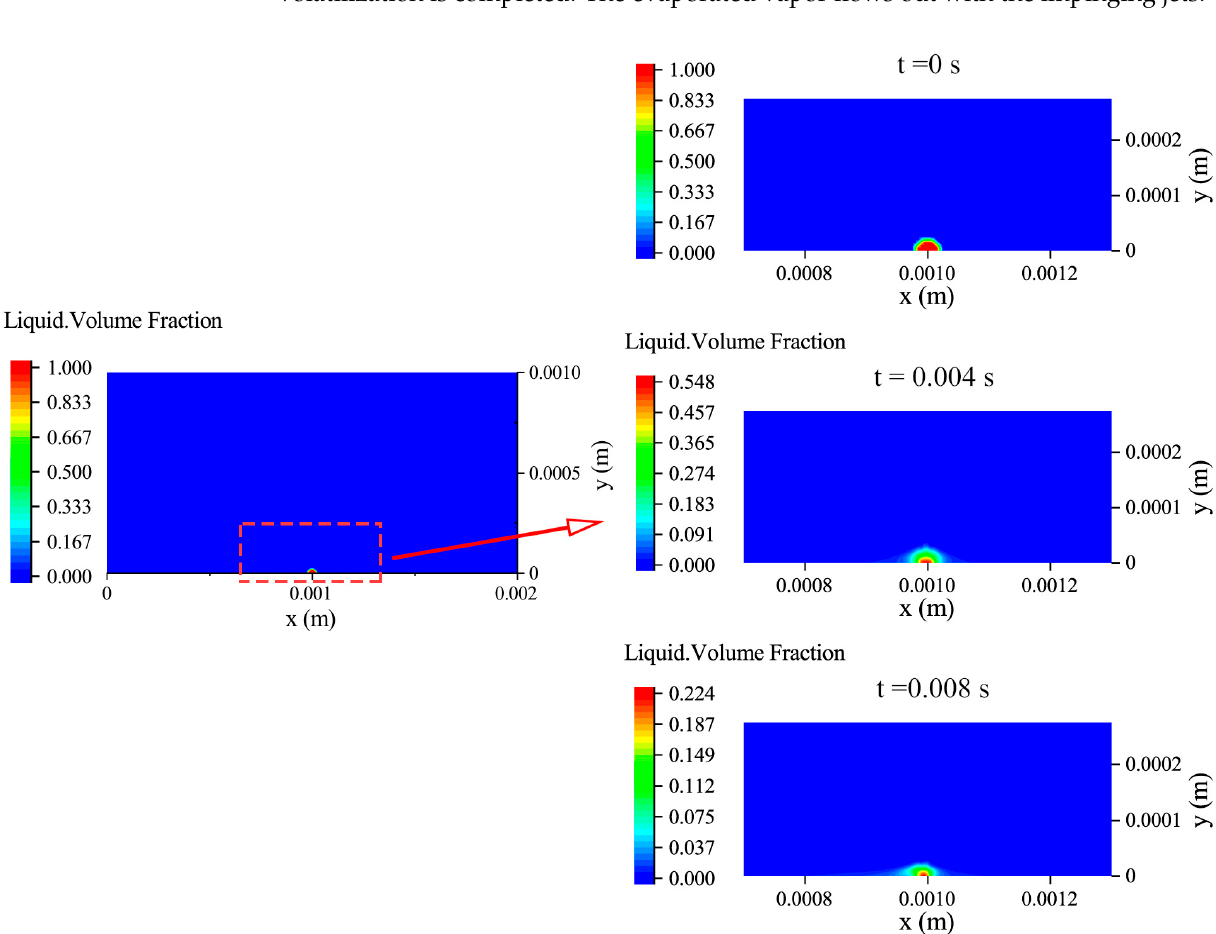
Figure 5. Variation in volume fraction of the water-based ink droplet at different times.